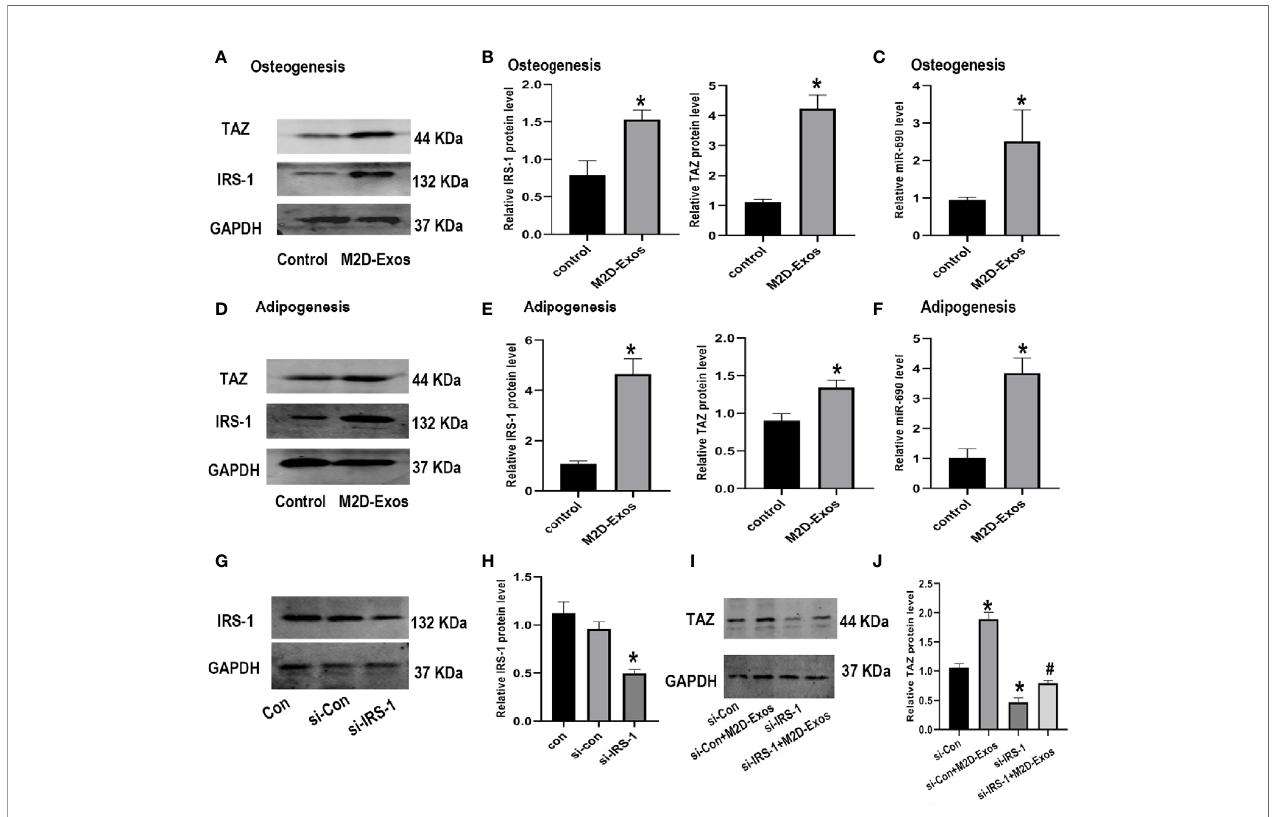
FIGURE 4 | Exosomes derived from M2 macrophages increased the level of IRS-1 and TAZ protein of BMSCs. (A, B) IRS-1 and TAZ protein of BMSCs after treated with M2D-Exos or PBS during osteogenesis were measured by western blotting analysis and quanti fi ed. Control group was BMSCs treated in osteogenic inducer. (C) The level of miR-690 of BMSCs after treated with M2D-Exos during osteogenesis were measured by qRT-PCR analysis. Control group was BMSCs treated in osteogenic inducer. (D, E) IRS-1 and TAZ protein of BMSCs after treated with M2D-Exos or PBS during adipogenesis were measured by western blotting analysis and quanti fi ed. Control group was BMSCs treated in adipogenic inducer. (F) The level of miR-690 of BMSCs after treated with M2D-Exos during adipogenesis were measured by qRT-PCR analysis. Control group was BMSCs treated in adipogenic inducer. (G, H) IRS-1 expression was analyzed using western blotting after transfected with different plasmids. (I, J) TAZ expression was analyzed using western blotting after different treatments. *p < 0.05 compared to the control